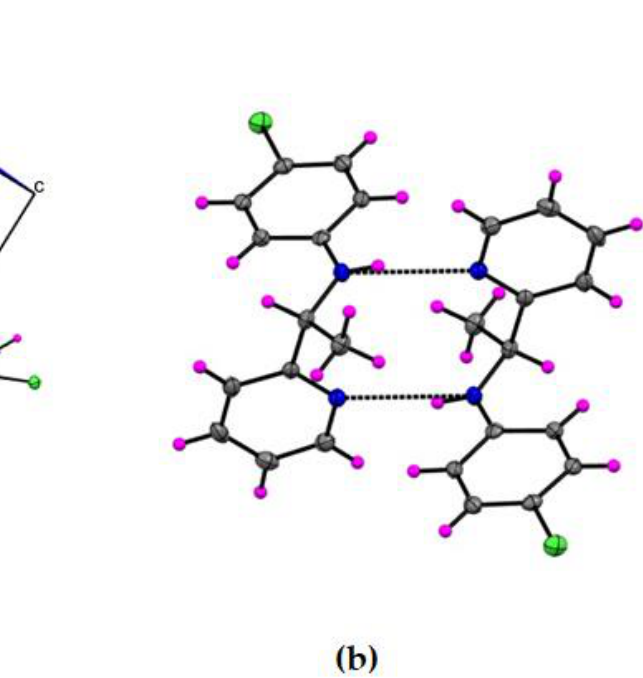
Figure 2. ( a ) The view of packing the diagram of L b molecules along the b axis. ( b ) A nitrogen-bonded dimer structure of L b formed via intermolecular H-N · · · · · · N nitrogen bonds. Atoms color: (a) blue = nitrogen, (b) pink = hydrogen, (c) green = chlorine, (d) grey = carbon.